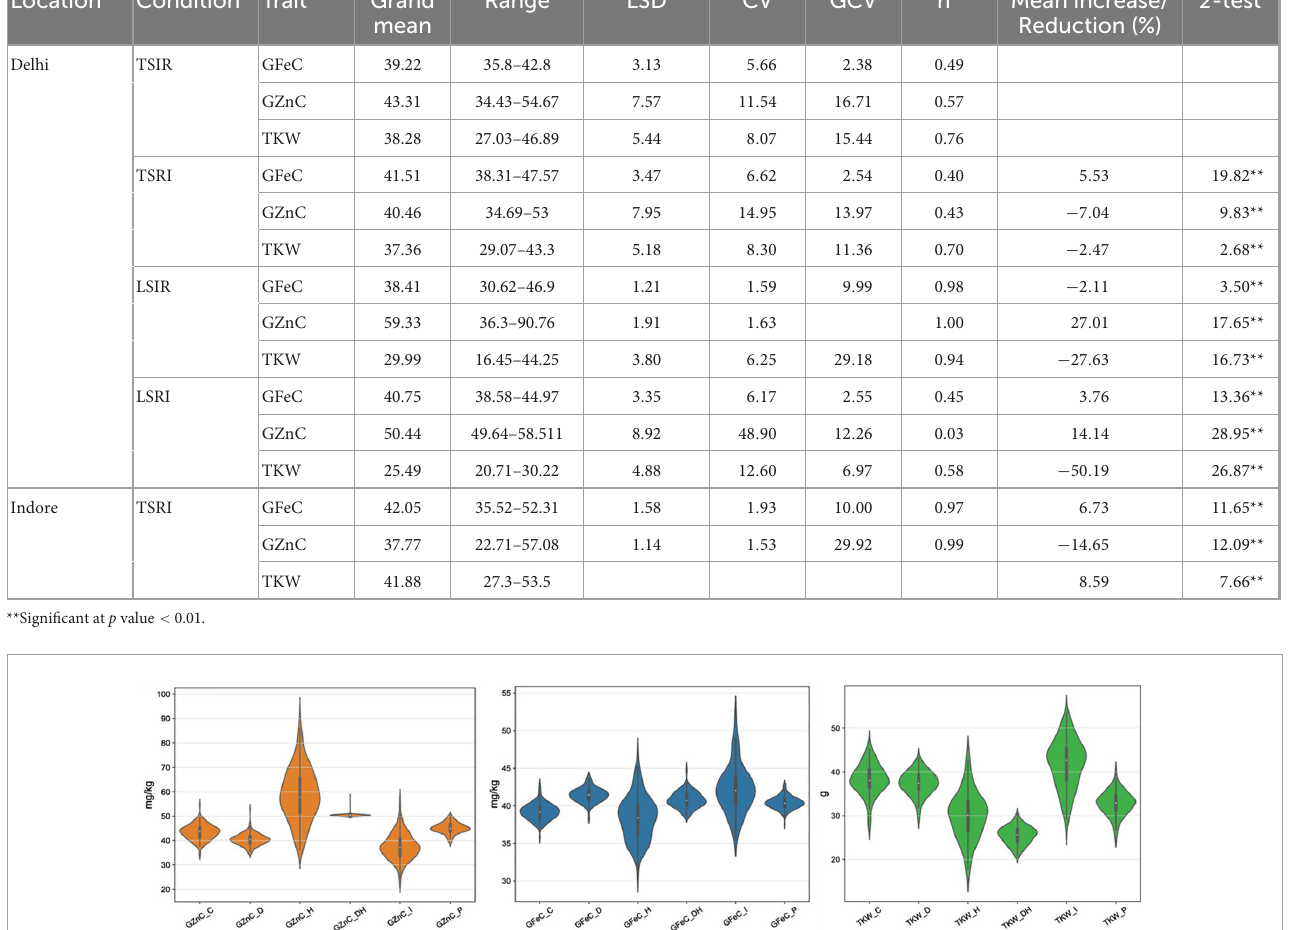
TABLE 3 Descriptive statistics, heritability, and percent mean increase/decrease under drought, heat, and combined stress. Location